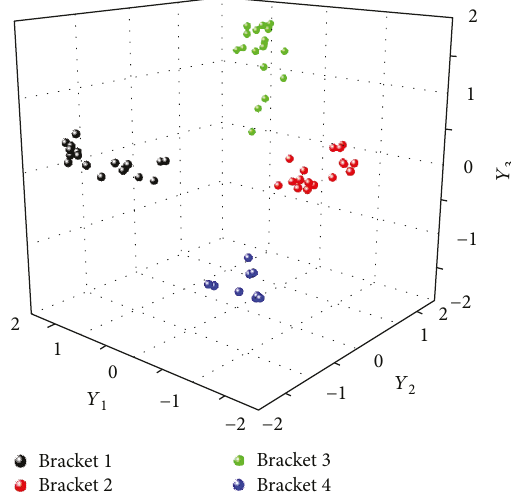
Figure 11: The 3D scatter plot of Y